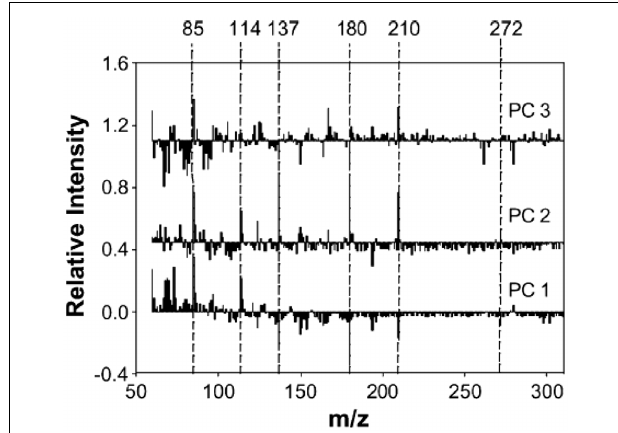
FIGURE 5 | Loadings from PCA of Py-mbms data for original and transgenic aspens; from top to bottom: PC3, PC2, PC1; C5 carbohydrates ( m / z 85 and 114) and lignin ( m / z 137, 180, 210, and 272) are highlighted for PC1 as reproduced from literature (Labbe etal., 2005).